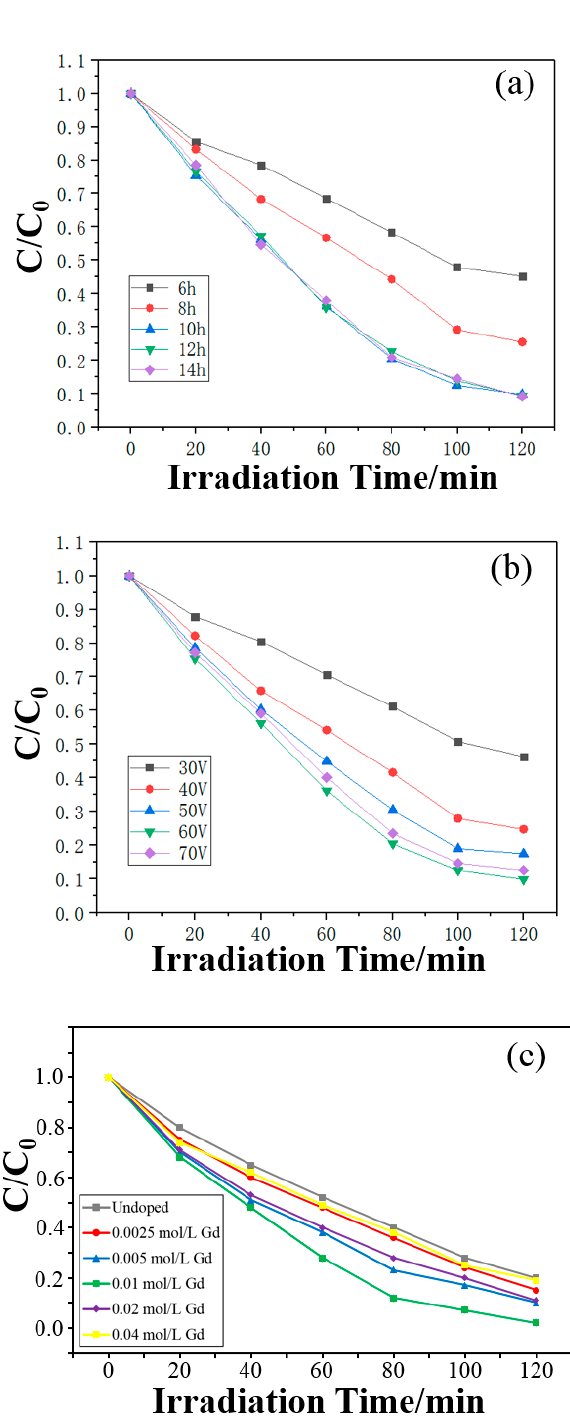
Figure 11. Concentration change of MO solution by TiO 2 nanotube arrays and Gd-doped TiO 2 at ( a ) different times (6 – 14 h), ( b ) different voltages (30 – 70 V) and ( c ) different Gd 3+ concentrations (0.0025 – 0.04 mol/L).